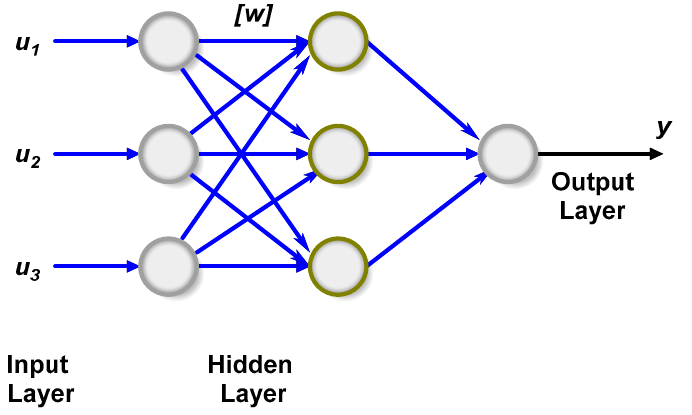
Figure 4. Perceptron (MLP) neural network.